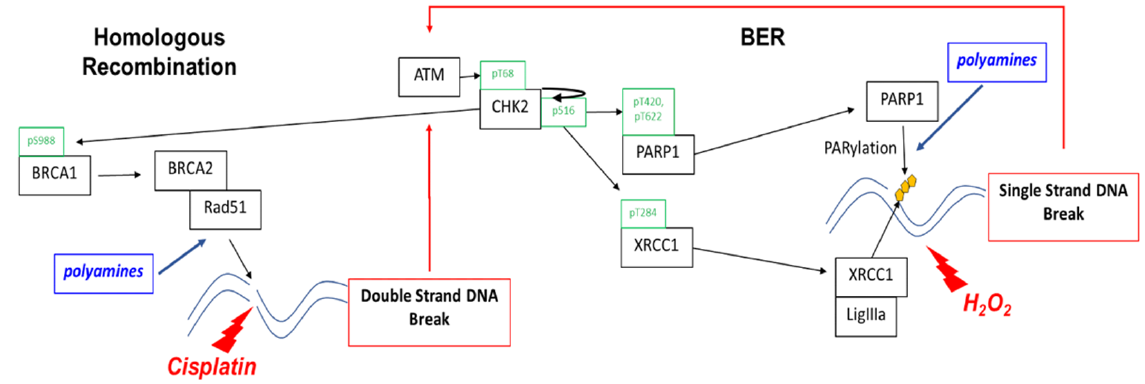
Figure 6. Polyamines contribute to the repair of single-strand and double-strand breaks. Homologous recombination enables cells to achieve high-fidelity repair of double-strand breaks and other complex DNA damage. PARP1 is essential for single-strand break (SSB) repair by binding to DNA at the sites of SSBs and recruiting repair machinery. PARP repair via the base excision repair (BER) pathway is the default repair pathway in HR deficient cells, such as that which occurs with loss of BRCA1 or BRAC2 function. As a DNA damage sensor and master regulator, ATM phosphorylates CHK2 at residue Thr68 followed by autophosphorylation at residue Ser516, activating CHK2 that phosphorylates proteins involved in both base excision repair and HR. CHK2 phosphorylation of PARP facilitates nuclear localization of PARP and enhances PARP activity. CHK2 also phosphorylates XRCC1 at the Thr284 residue, enhancing its interaction with sites of DNA damage and promoting base excision repair. Polyamines are PARP1 cofactors and enhance PARP activity in ssDNA break repair. Polyamines enhance DNA strand exchange activity of Rad51 recombinase in HR repair and may also contribute to PARylation of dsDNA break repair proteins.